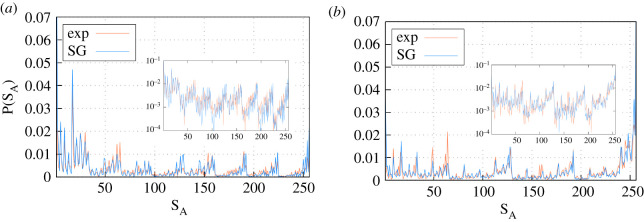
Probability distribution of states (the x-axis contains the 28 = 256 possible states) for the experimental data and the spin-glass approach for (a) regime A and (b) regime B. The insets show the same probability distributions in the logarithmic scale. For further details on the goodness of the model, see appendix B.